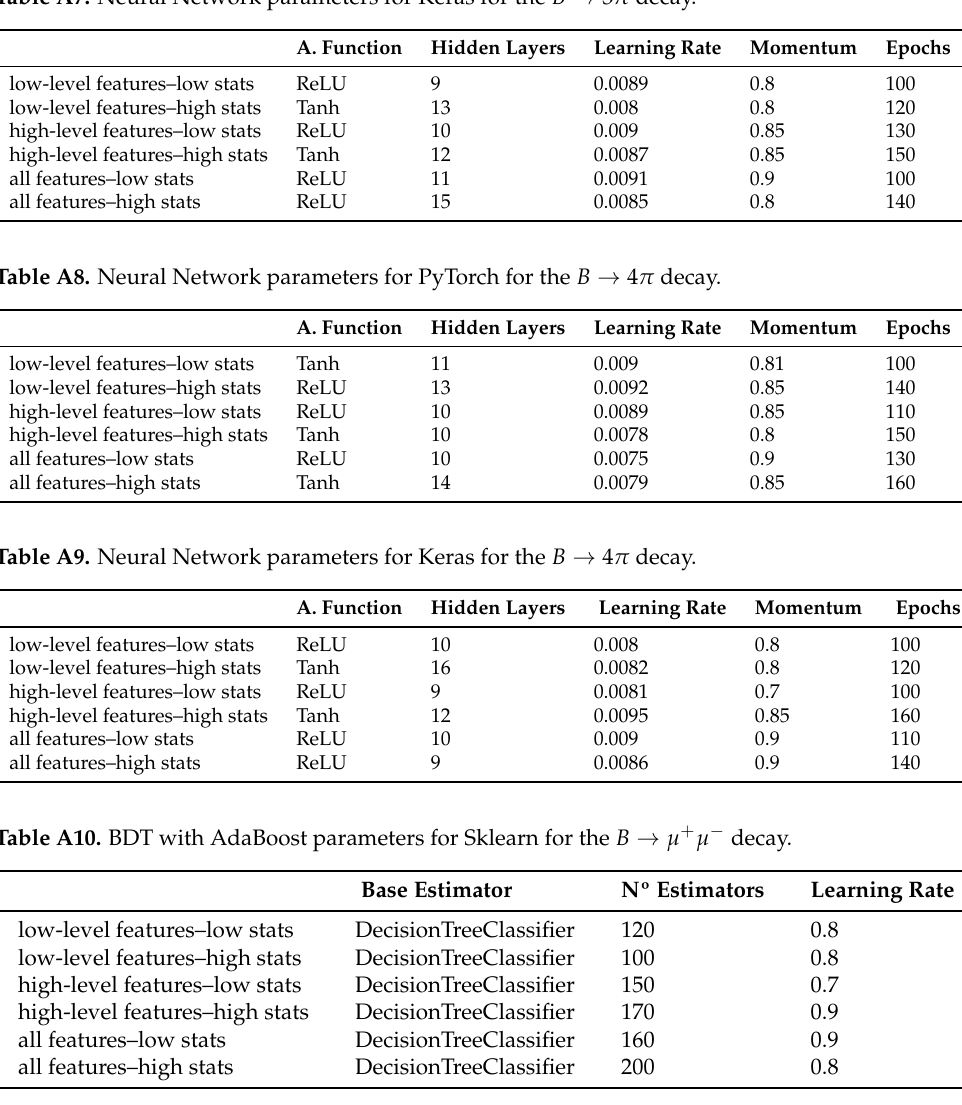
Table A7. Neural Network parameters for Keras for the B